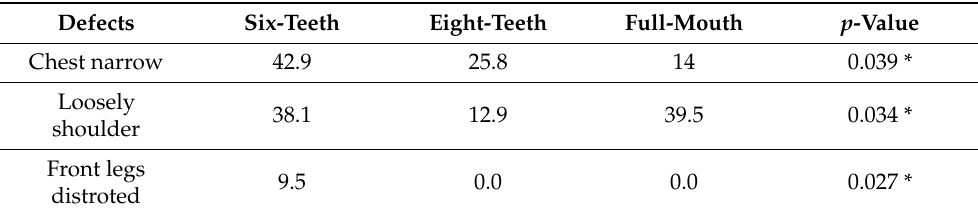
Table 7. Presence of significant defects in structural traits of Creole cows (N = 95) according to age (%) 1